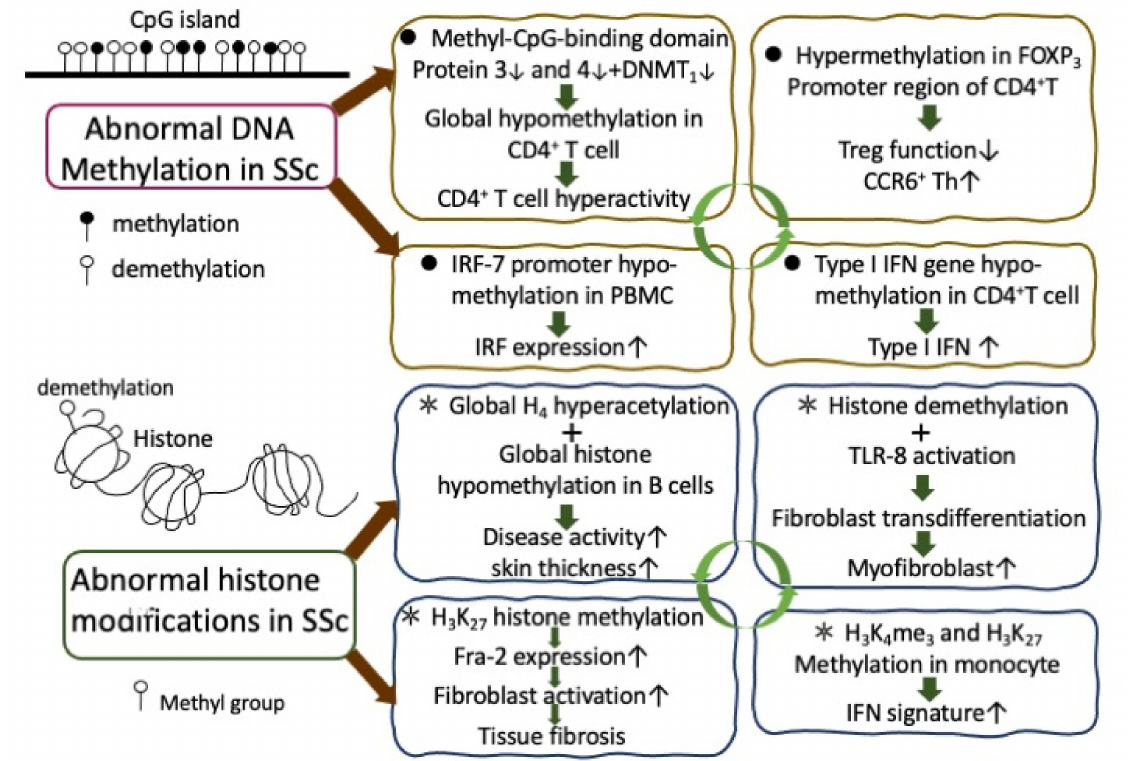
Figure 2. A number of abnormal epigenetic regulations on DNA methylation of the CpG islands in gene promoter regions (upper panel) and histone modifications (lower panel are found in patients with SSc). These deranged epigenetic regulations may result in chronic inflammation, immune dysfunction, and finally tissue fibrosis. IRF: interferon regulatory factor; IFN: interferon; TLR: Toll-like receptor; Treg: regulatory T cell; H: histone; K: lysine residue.